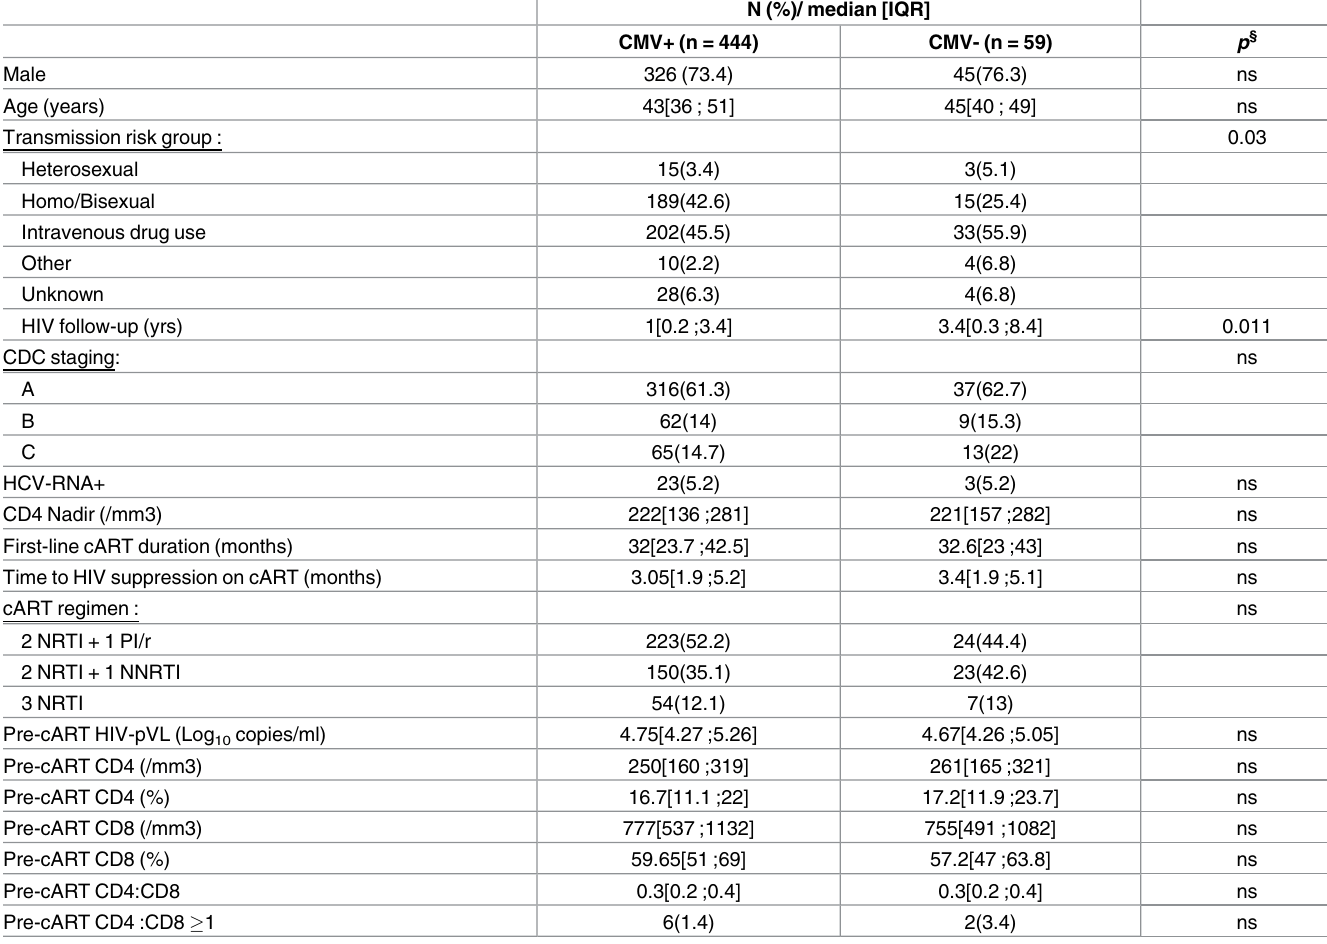
Table 1. Patients’ characteristics at the time of cART